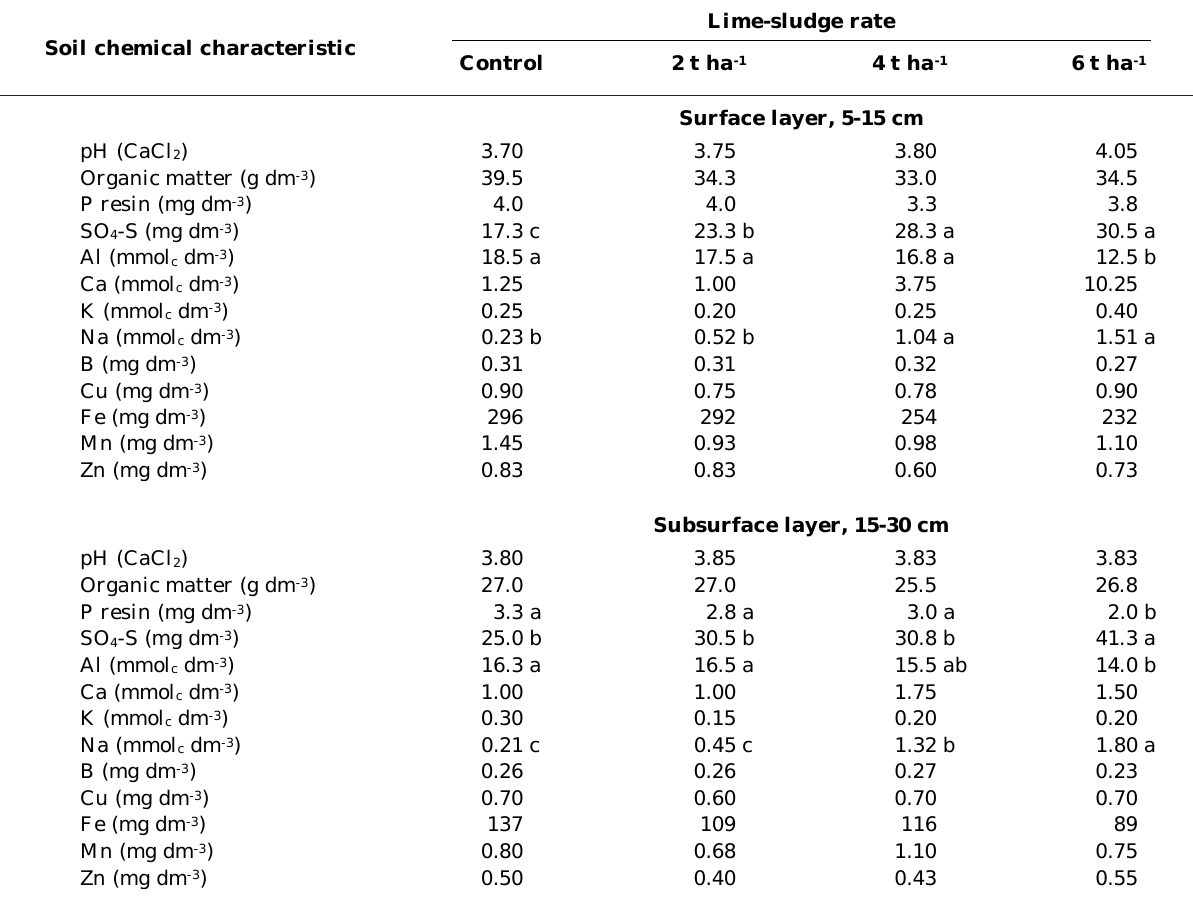
Table 4. Effect of lime-sludge rates on the soil chemical characteristics at two